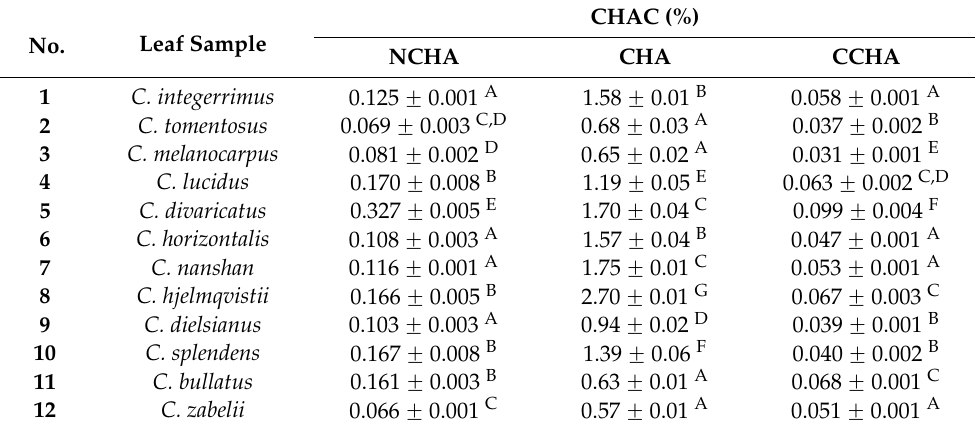
Table 3. Total content of chlorogenic acid isomers (CHAC) in the Cotoneaster leaf extracts a .